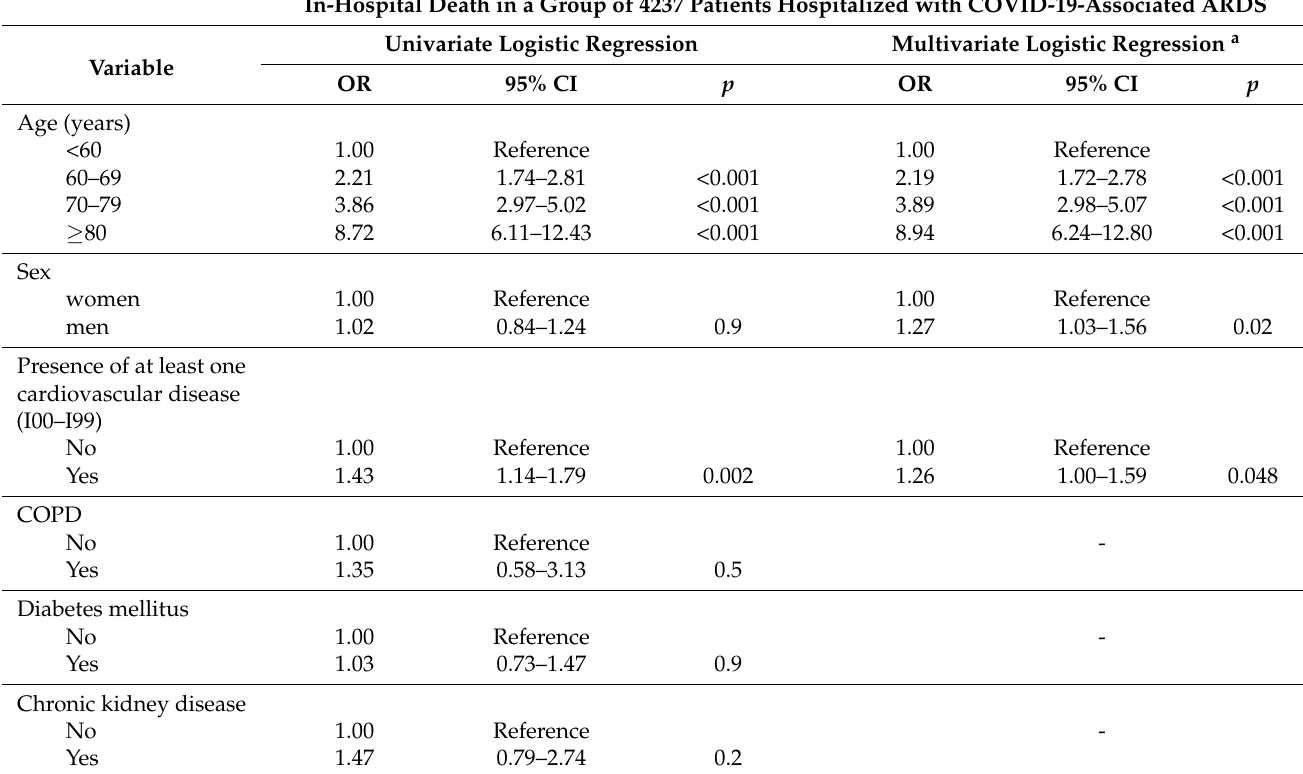
Table 4. Odds ratios (OR) and 95% confidence intervals (CI) for in-hospital death in a group